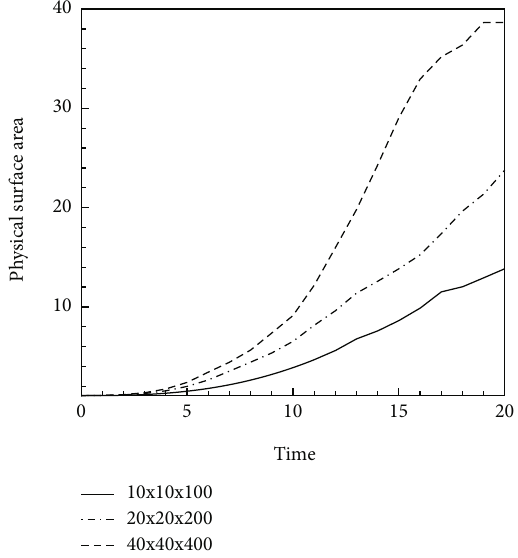
Figure 6: Plot of the interface surface area vs. time using physical units. Results for three mesh levels are displayed for the identical 3D single-mode RT